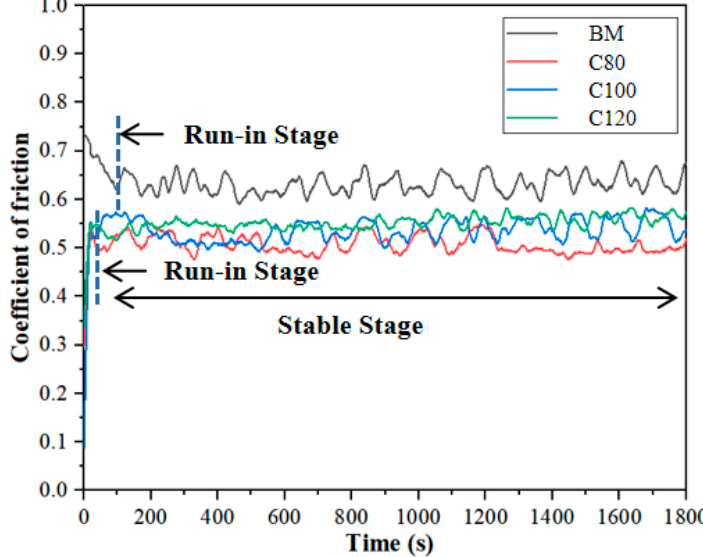
Figure 10. Friction coefficient–time curves of the test specimens.